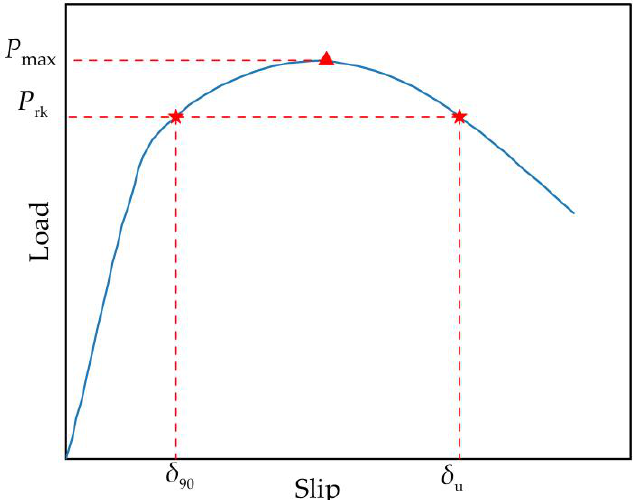
Figure 10. Evaluation of shear resistance and ductility. Table 3. Mechanical properties of shear